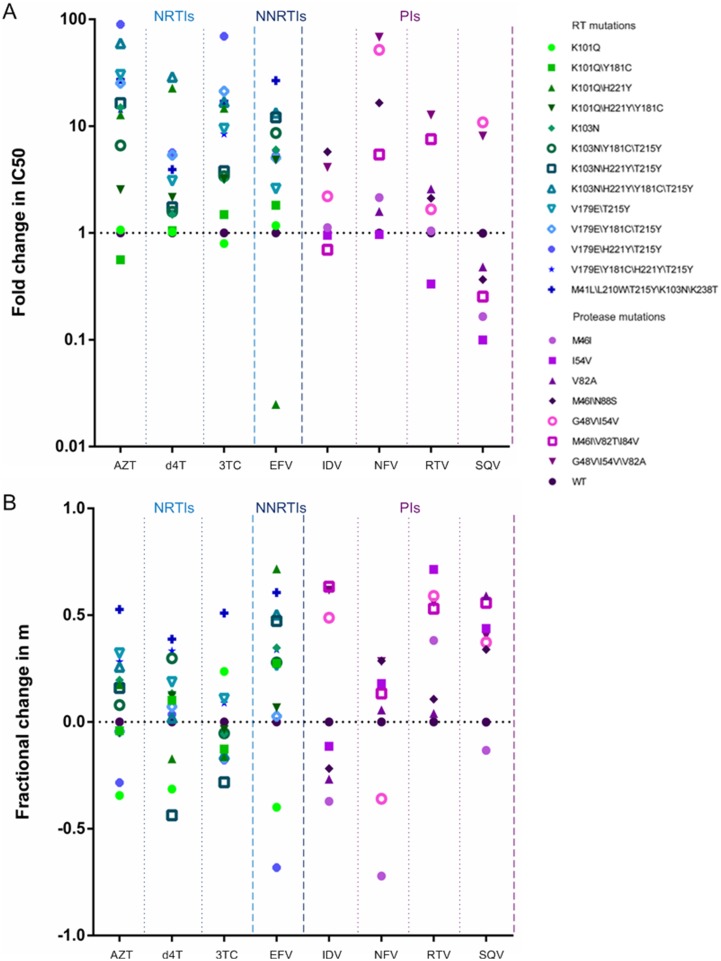
Effects of various resistance mutations on (A) IC50 and (B) slope, as calculated from dose-response curves.Fold changes in IC50 for mutants were relative to those for the wild-type virus, and fractional changes in slope were computed using equation (2). The drugs tested are grouped by class: NRTIs, NNRTI, and PIs. Within each class, different shapes indicate the various mutants.